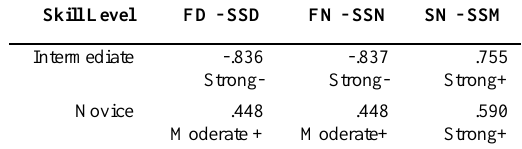
Table 4. Eye- Hand Correlation Results for Scenario-1 Skill Level